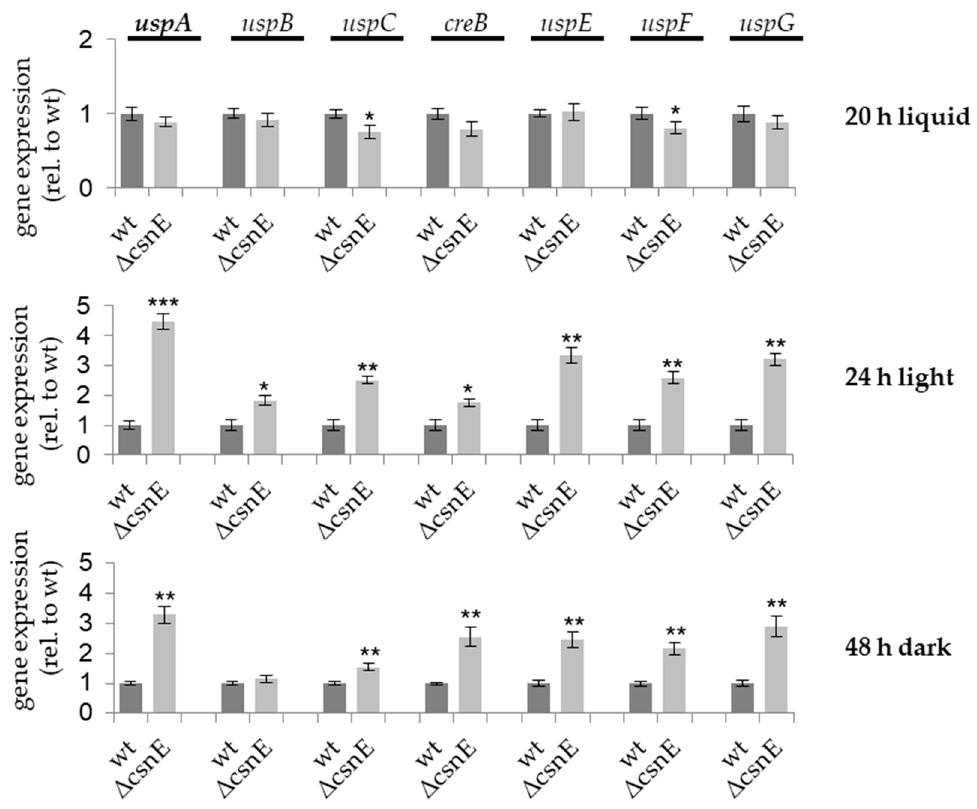
Figure 1. The expression of usp encoding genes depends on CsnE during the multicellular development of A. nidulans . Fungal strains were grown for 20 h in liquid cultures and mycelia were harvested or afterwards shifted onto solid agar plates and incubated for 24 h in light to initiate asexual development or for 48 h in darkness to initiate sexual development at 37 ◦ C, respectively. RNA was isolated from these samples and cDNA was transcribed. qRT-PCRs were performed with h2A and 15s rRNA as reference genes. Wild type expression was set to one. Standard deviations are shown that derive from up to four biological replicates with three technical replicates each (*** p ≤ 0.001; ** p ≤ 0.01, * p ≤